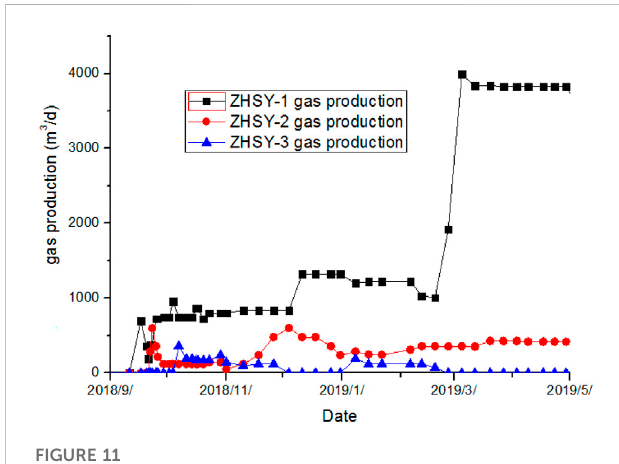
FIGURE 11 Gas production change of the CBM